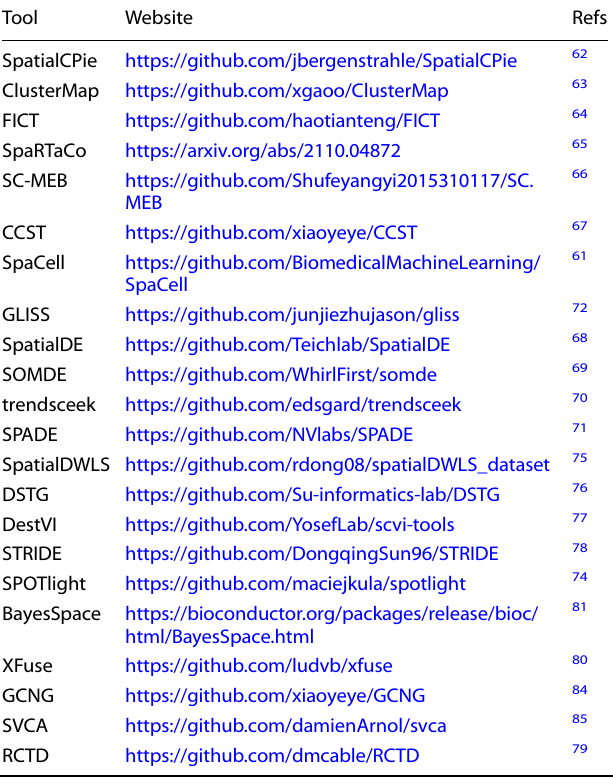
Table 2. Representative bioinformatics tools of ST